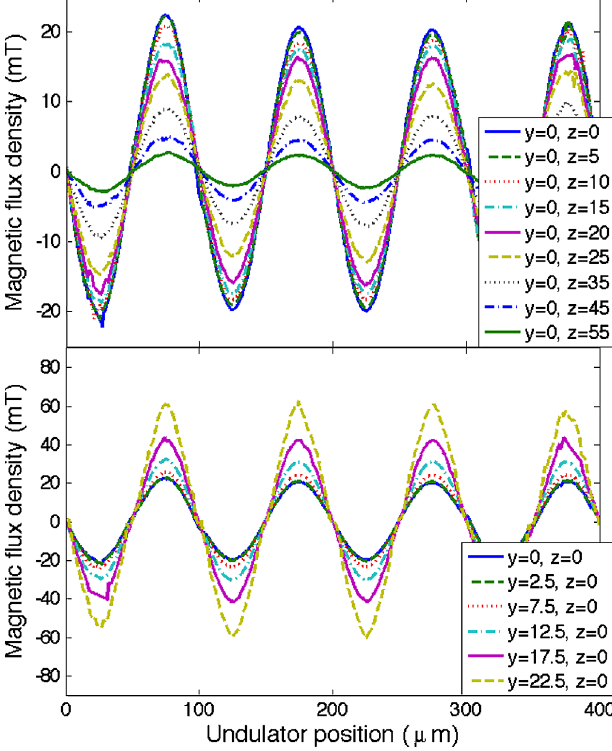
center.FIG. 9. Transverse magnetic flux density at different positions ¼ 100 (cid:1) m and g ¼ 50 (cid:1) m . The plot for Design 1 with (cid:2) u spans 5 of 7 periods of an undulator with y ¼ z ¼ 0 (cid:1) m at the